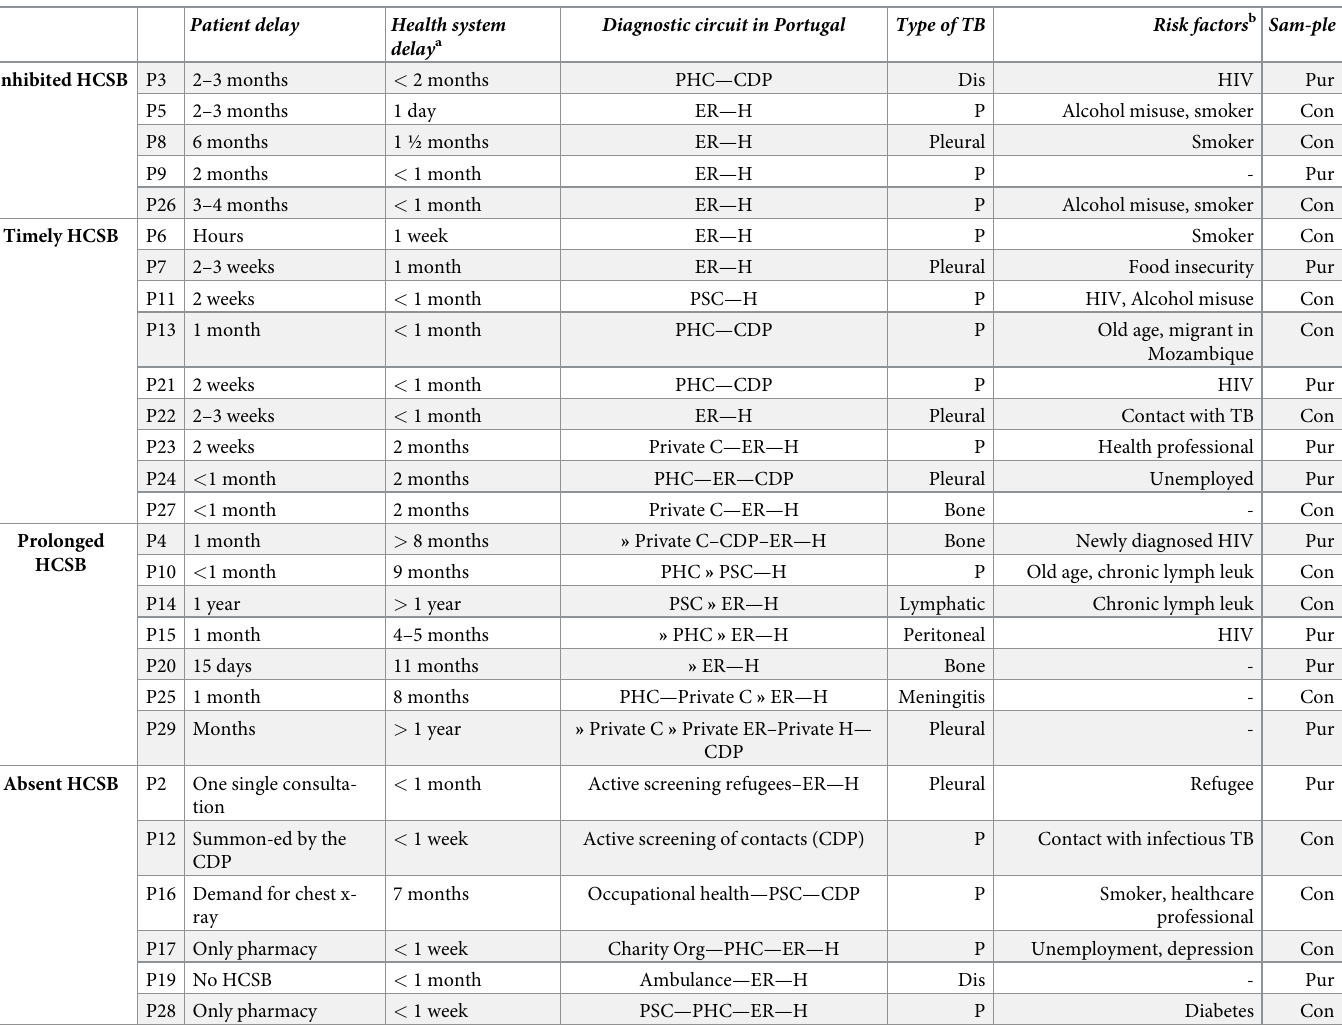
Table 2. Participants´ delays, diagnostic circuits, and TB types, grouped according to their